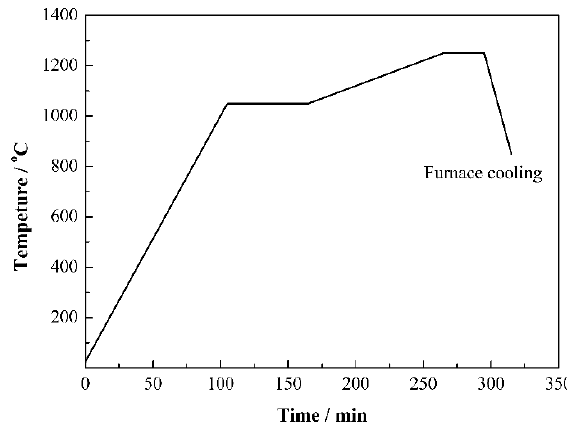
Figure 2. Sintering curve of Mo 2 FeB 2 based cermets.